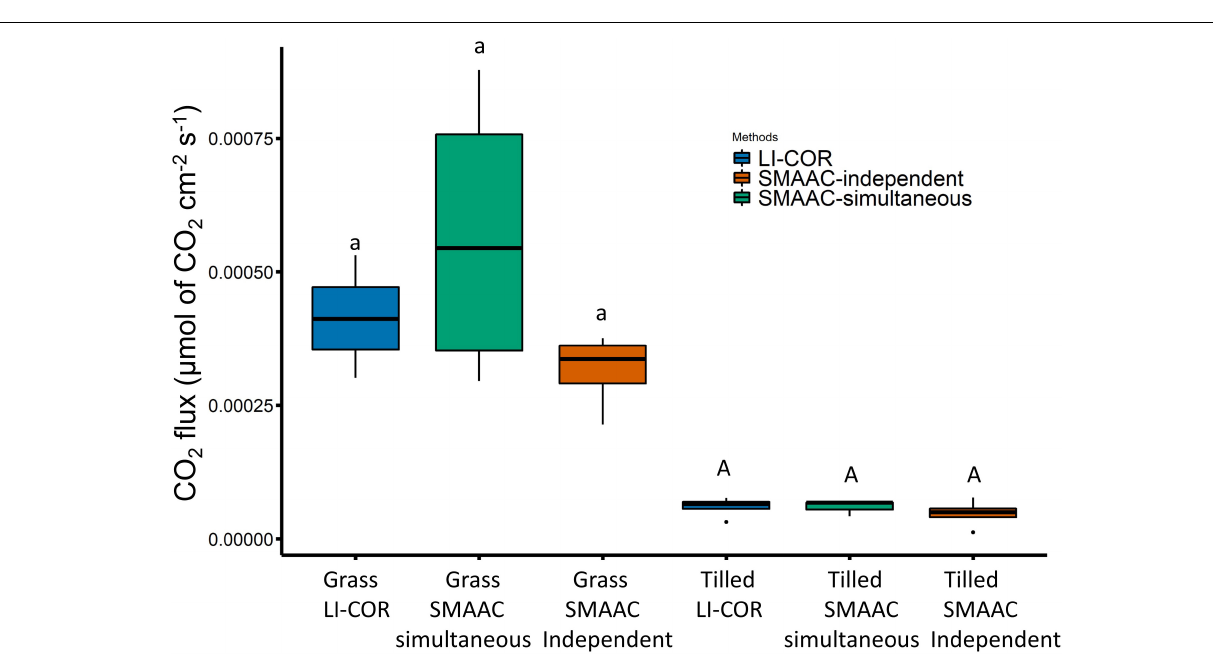
FIGURE 2 | Measurement setups for: (a) SMAAC-Biomass substrate induced respiration (SIR) measurement; (b) SMAAC-Field flux measurement with SMAAC simultaneously located within the LI-COR 8100 sampling chamber; (c) SMAAC-Field flux measurement with SMAAC independent of the LI-COR unit; and (d) SMAAC-Burst laboratory CO2 burst